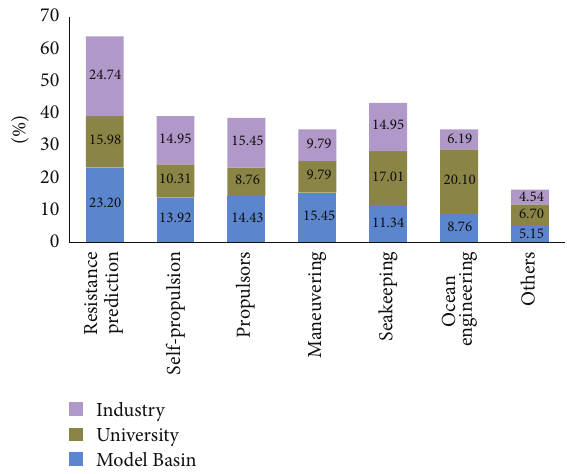
Figure 3: Applications of CFD in marine hydrodynamics.